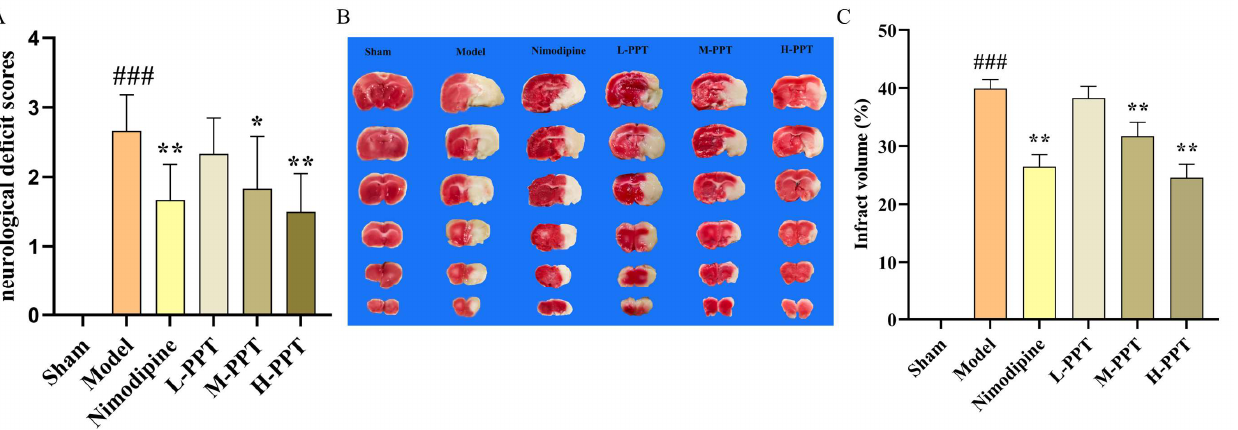
Figure 1. ( A ) The impact of PPT on the viability of PC12 cells. ( B – F ) Effects of PPT on LDH, MDA, SOD, TNF- α , and IL-6 levels in OGD-P12 Cells. ( n = 6); Compared with the control group, ## p < 0.01, ### p < 0.001; compared with the model group, * p < 0.05, ** p < 0.01, *** p < 0.001.